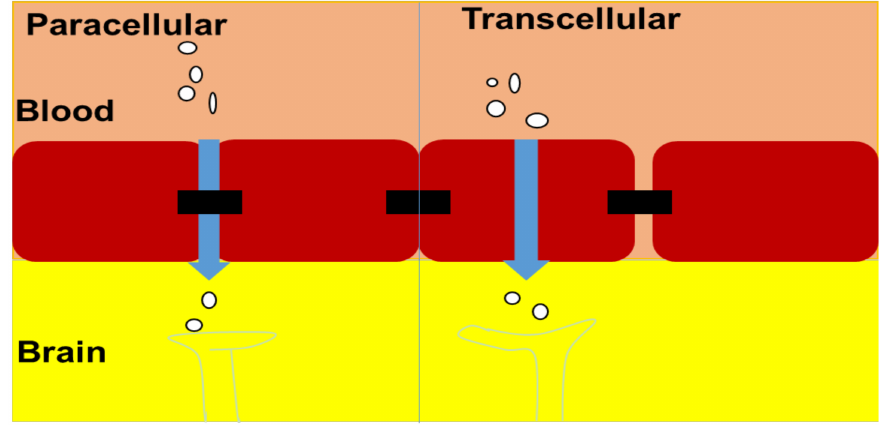
Figure 3. Mode of transportation across the brain.